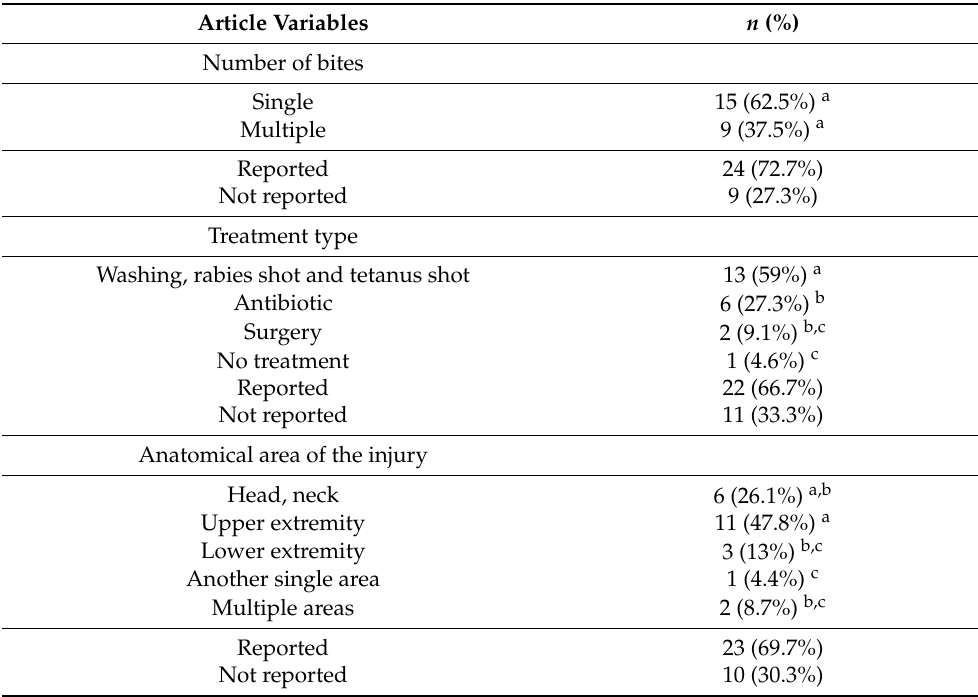
Table 5. Characteristics of the injuries and treatment of the victim collected from 33 articles on dog bites resulting in death.